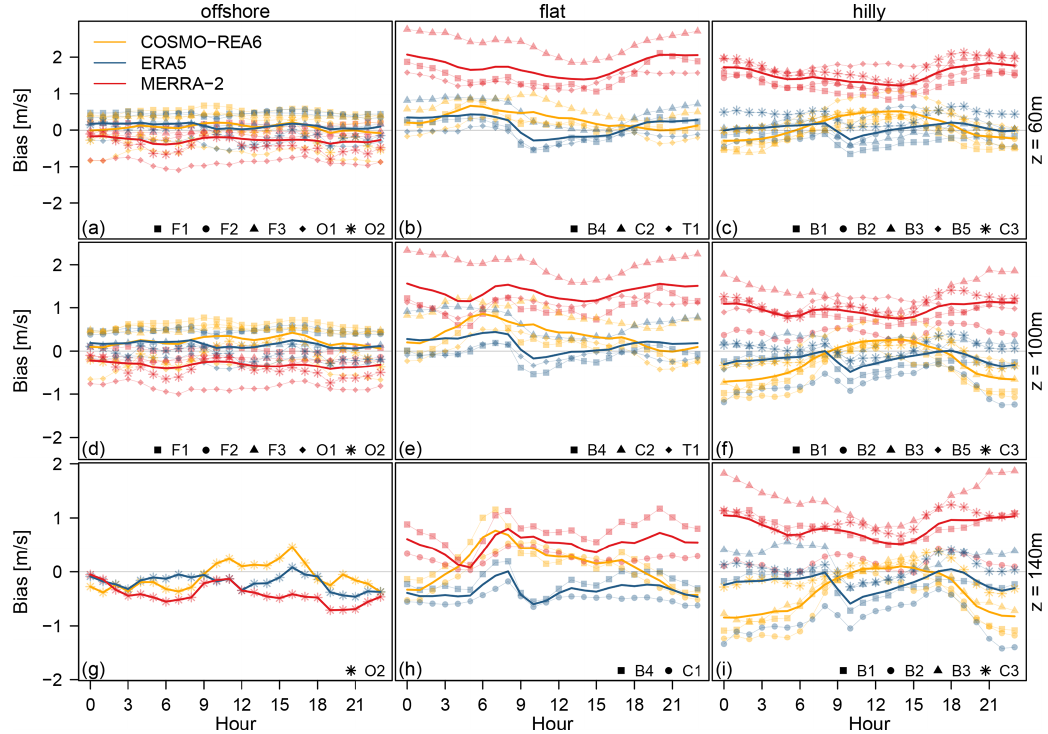
Figure 5. Lines show the average diurnal cycle of wind speed bias at (a–c) 60m, (d–f) 100m and (g–i) 140m for COSMO-REA6 (orange), MERRA-2 (red) and ERA5 (blue). Symbols indicate the offshore locations (a, d, g) , flat (b, e, h) and hilly terrain (c, f, i) .